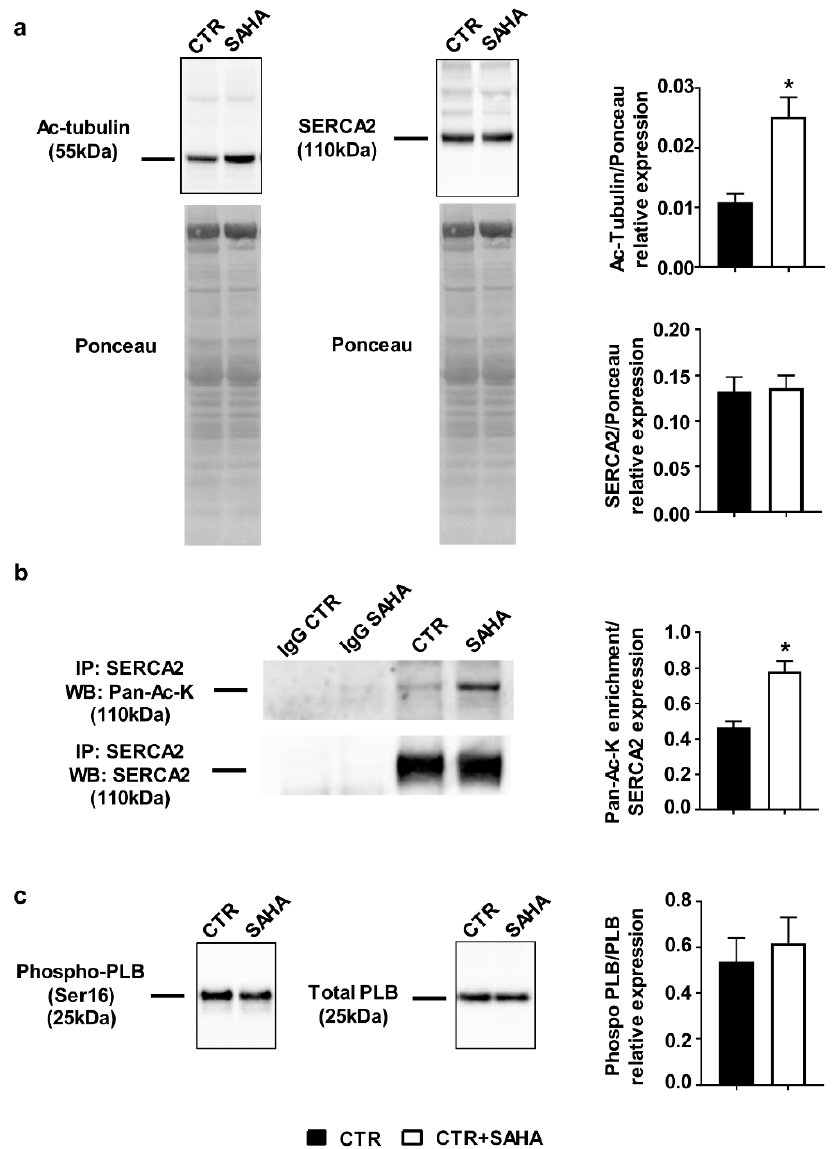
Figure 1. Effect of SAHA treatment on cardiomyocytes isolated from adult rat hearts. ( a ) Western blot panels ( on the left ) and densitometric analysis ( on the right ) showing SERCA2 and Ac-Tubulin protein expression after SAHA treatment ( n = 7). Mann–Whitney U -test: * p < 0.005 vs. CTR; ( b ) Immunoprecipitation experiments and densitometric analysis ( on the right ) indicating higher acetylation level of SERCA2 after SAHA treatment ( n = 5). Mann–Whitney U-test: * p < 0.005 vs. CTR; ( c ) Western blot analysis showing the expression of phosphorylated phospholamban (Phospho-PLB, Ser16) compared to total phospholamban (PLB) in adult rat CMs after SAHA treatment ( n = 7).